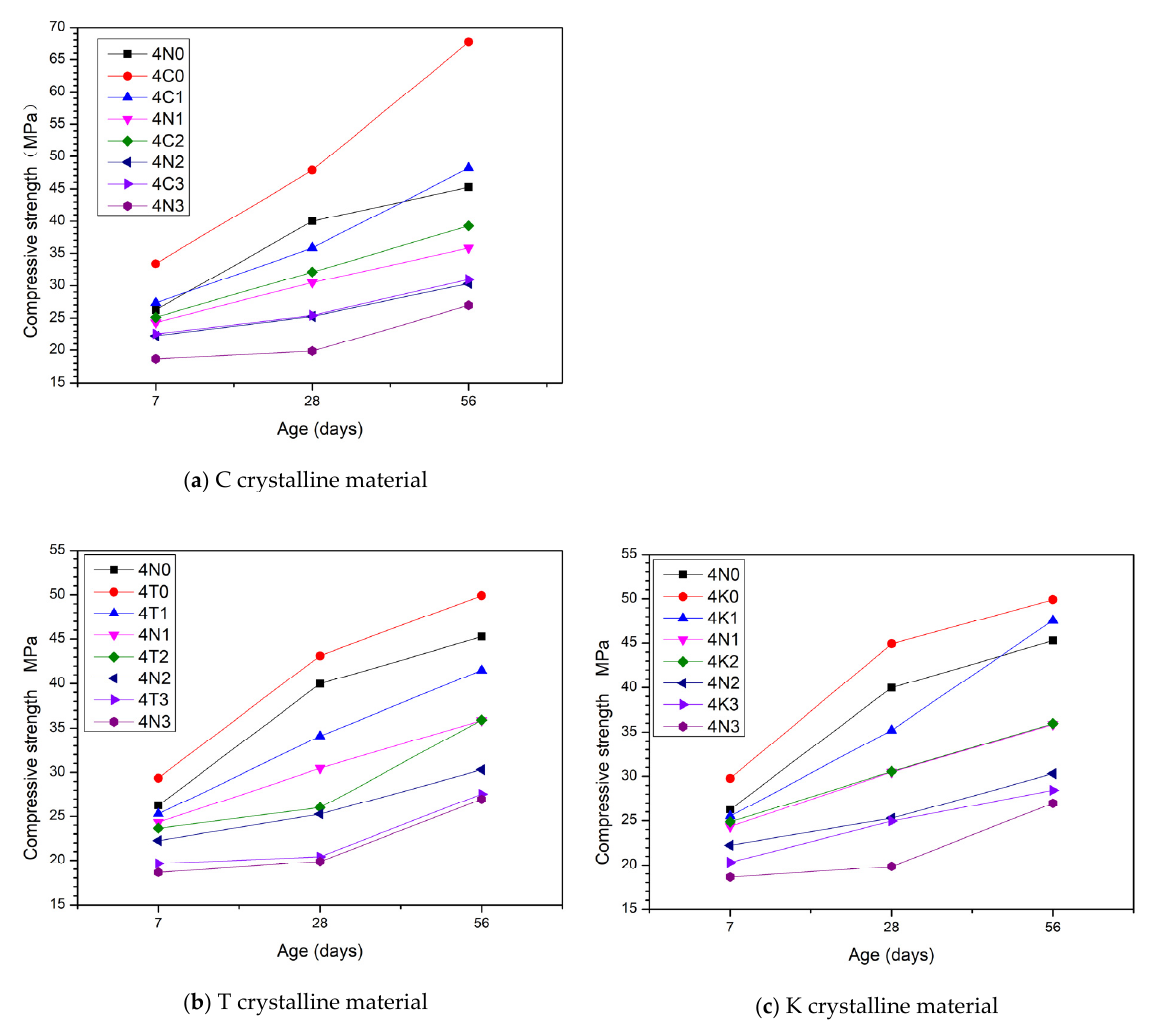
Figure 2. Compressive strength of cement mortar when W/C = 0.4.